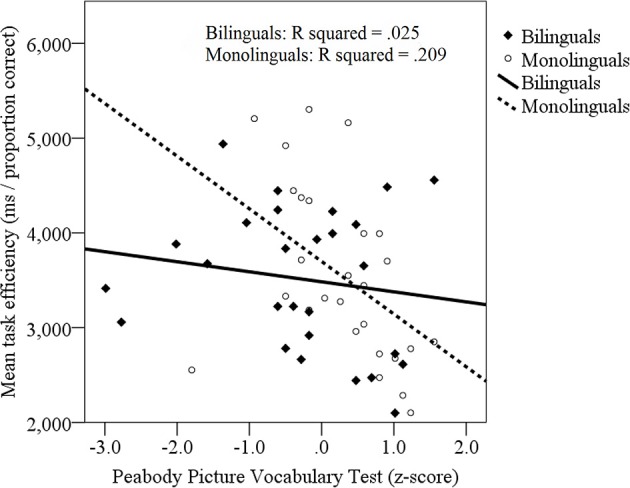
Relationship between target identification efficiency (ms/proportion correct) during sound-to-symbol matching and participants' performance on the Peabody Picture Vocabulary Task (PPVT, z-transformed). Bilinguals: filled diamonds, solid line; Monolinguals: open circles, dotted line.